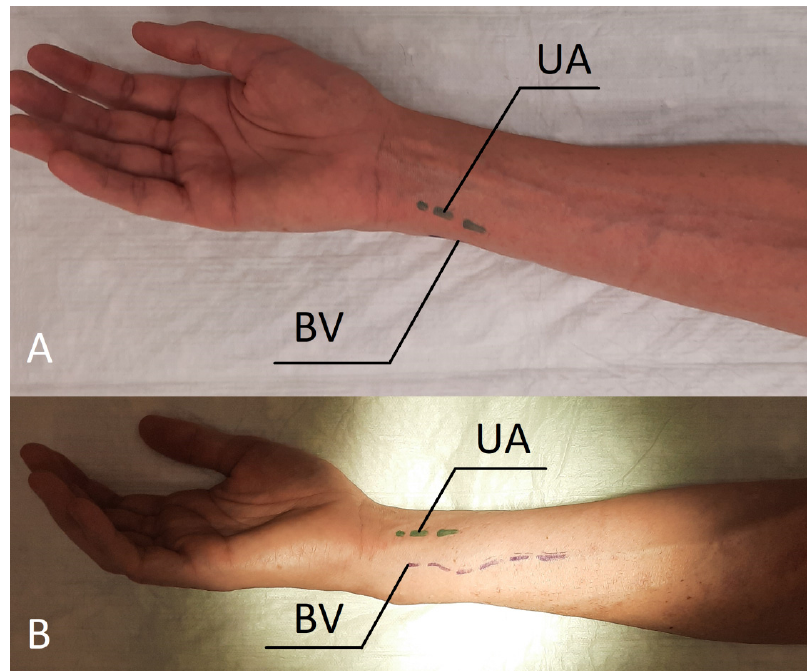
Figure 1. ( A ) Patient in supine position with external rotation of the right forearm, intermittent lines on the skin show the course of the ulnar artery—from this aspect, the basilic vein is not visible. ( B ) Patient in prone position, intermittent lines on the skin show the course of the vessels. Abbreviations: UA—ulnar artery, BV—basilic